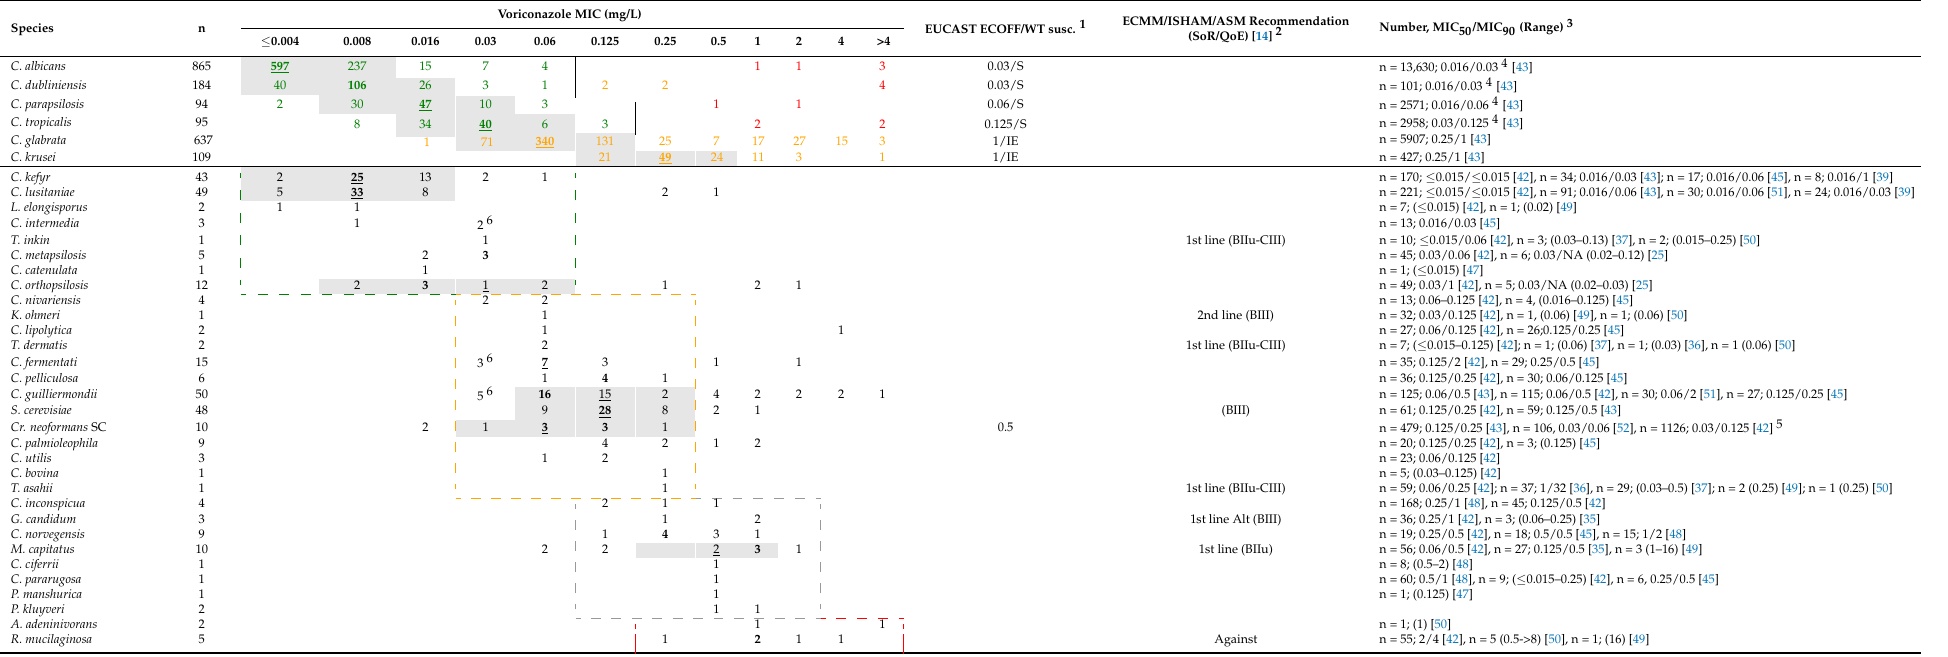
Table 7. Voriconazole EUCAST MICs against Danish common and rare yeast species sorted by increasing MICs. The coloured boxes indicate the intrinsic relative susceptibility (S (green)/I (orange)/R (red)/Unkown (grey)) of wild-type isolates of a given